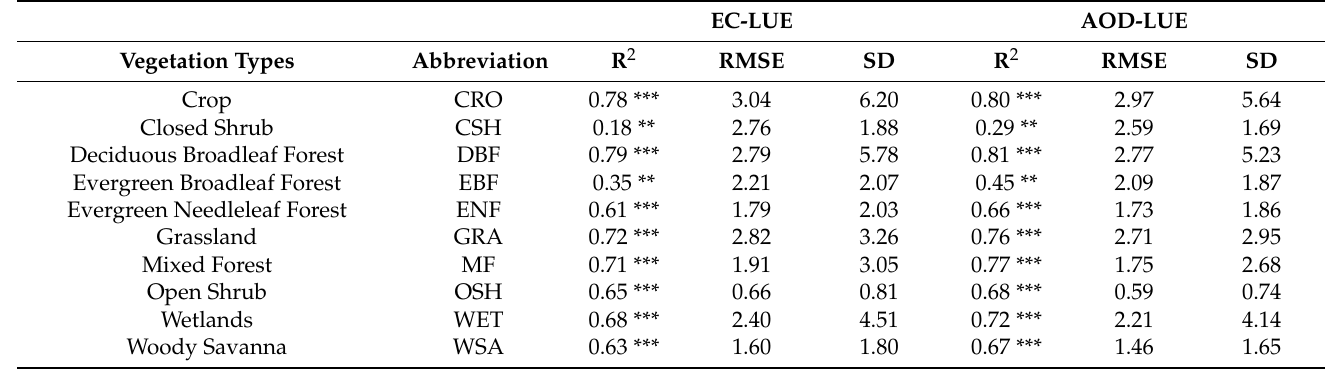
Figure 5. ( a ) Comparison of GPP (g C m − 2 day − 1 ) calculated by EC-LUE model and AOD-LUE model with GPP based on EC flux towers. The dotted red line shows the intersection of the two models. ( b ) illustrates how the AOD-LUE model compares with the EC-LUE model when the changed percentage value of R 2 ((AOD-LUE − EC-LUE)/EC-LUE) × 100) varies with the R 2 value of the EC-LUE model. Table 1. The performance of AOD-LUE and EC-LUE in simulating GPP for each vegetation type. EC-LUE